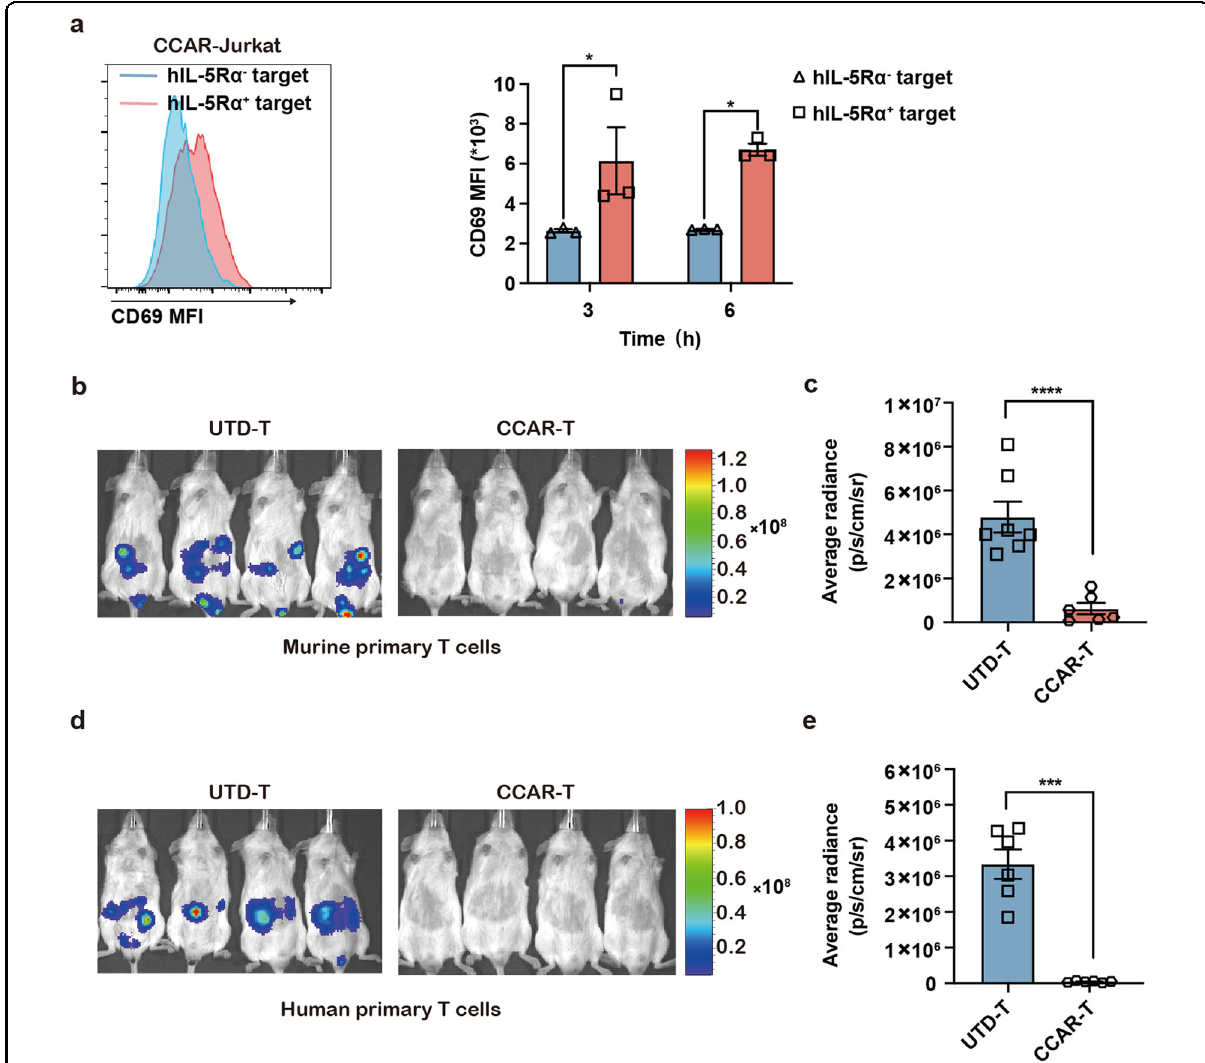
Fig. 2 Functional assessment of hIL-5-anchored CCAR-cells in vivo. a fl ow cytometry analysis of the CD69 expression on the CCAR-Jurkat cells 3 h or 6 h after the NCG mice were injected intraperitoneally with hIL-5R α + U2OS cells and hIL-5-anchored CCAR-Jurkat cells. Two-tailed t -test, * P < 0.05. b Representative bioluminescence images showing the target cell burden in the NCG mice 24 h after the hIL-5R α + U2OS cells expressing fi re fl y luciferase and the murine primary CCAR-T cells/UTD-T cells were intraperitoneally injected. c The quanti fi cation of the target cell burden in mice from b . Two-tailed t -test, **** P < 0.0001. d Representative bioluminescence images showing the target cell burden in the NCG mice 24 h after the hIL-5R α + U2OS cells expressing fi re fl y luciferase and the human primary CCAR-T cells/UTD-T cells were intraperitoneally injected. e The quanti fi cation of the target cell burden in mice from d. Two-tailed t -test, *** P <